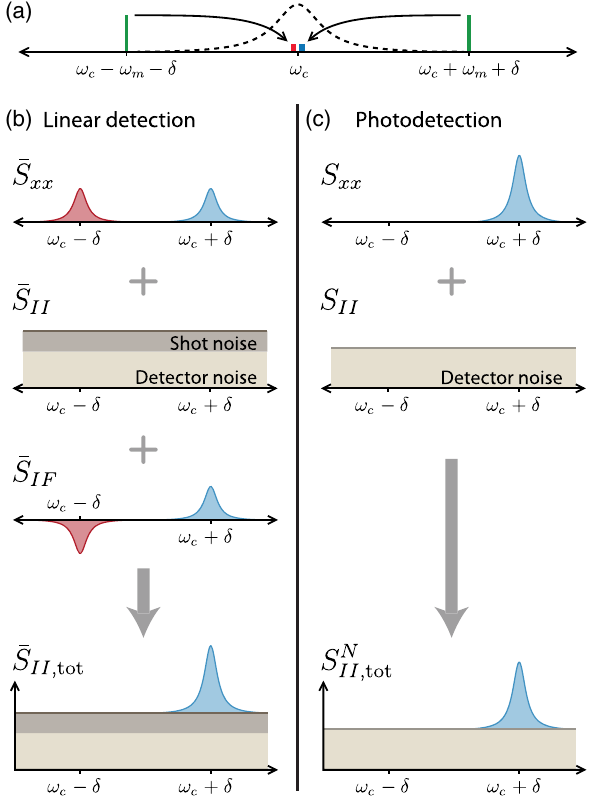
FIG. 1. Comparison between linear detection and photodetec- tion. (a) Pump scheme. We consider a single microwave cavity ω δ Þ (green bars). The up- (dotted line) pumped at ω c (cid:2) ð m þ converted (red bar) and down-converted (blue bar) motional sidebands are placed tightly within the cavity linewidth. For figure clarity, the occupations of the microwave and mechanical modes are assumed to be zero. (b) Linear detection. The quantum ¯ S contribution from the symmetrized motional noise is present xx in both sidebands. Microwave shot noise (brown band) and amplifier noise (beige band) combine to form the imprecision ¯ S noise . This measurement is sensitive to noise correlation II ¯ S between the microwave and mechanical modes ( ), which IF results in asymmetric squashing (red region) and antisquashing (blue region) of the noise floor. (c) Photodetection. Normal- ordered detection is sensitive to the asymmetric motional noise spectrum S . The detector is not sensitive to microwave shot xx noise, and the noise floor ( S ) is from detector nonidealities II (beige band), analogous to dark counts for a photodetector. Although the source is different, the sideband imbalance is identical in both photodetection and linear detection. For math- ematical descriptions of S and S , refer to Appendix II IF